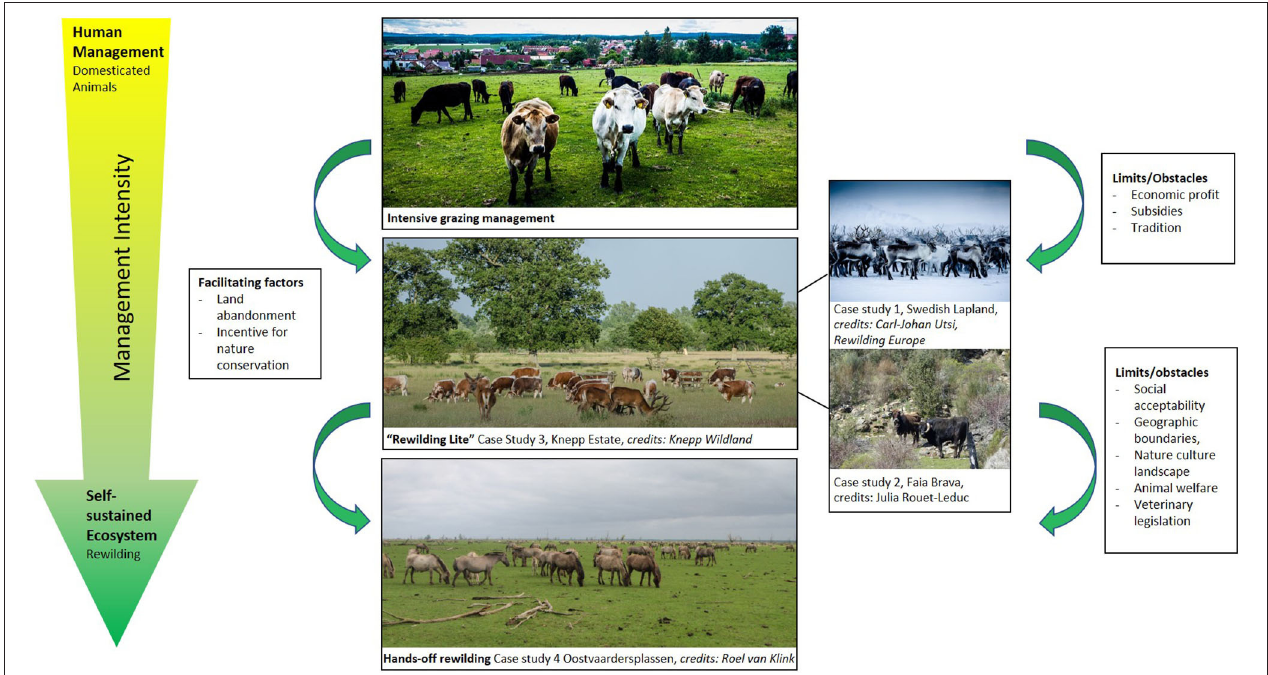
FIGURE 2 | Schematic representation of how different types of land managements with large herbivores are facilitated or hindered by different factors. Our case studies are all situated within the second type of land management, that is rewilding with domestic animals. The top panel represents traditional rearing of animals with high management intensity, and the bottom panel represents “hands-off” rewilding (i.e. “rewilding max”) with minimal human intervention, in this case